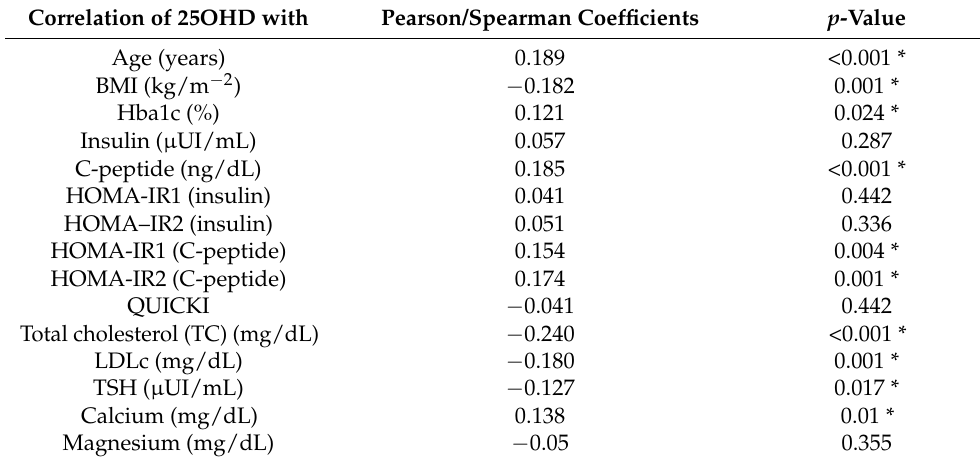
Table 2. Correlation analysis for the study sample ( n =